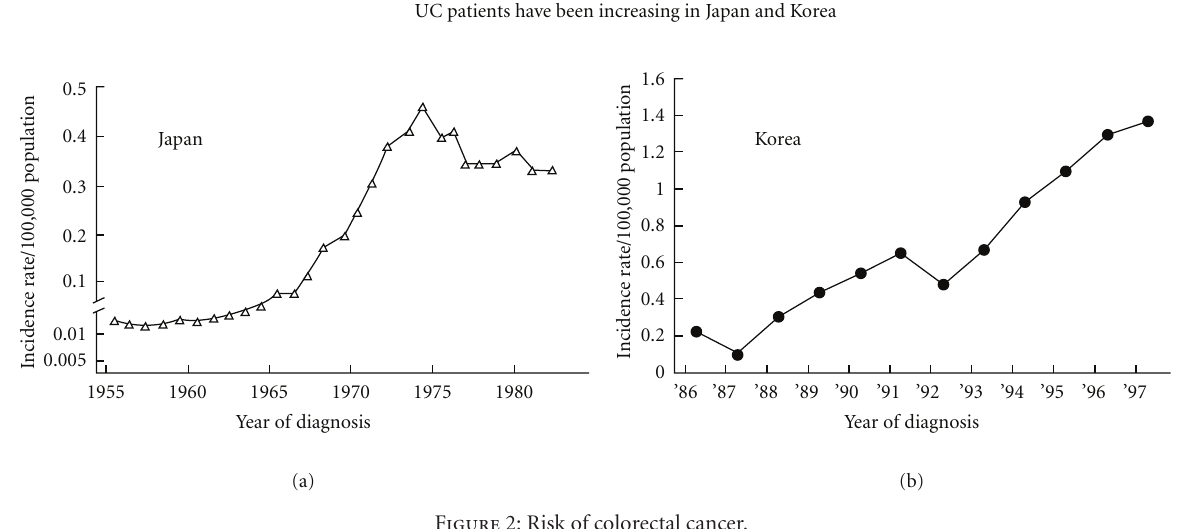
Figure 2: Risk of colorectal